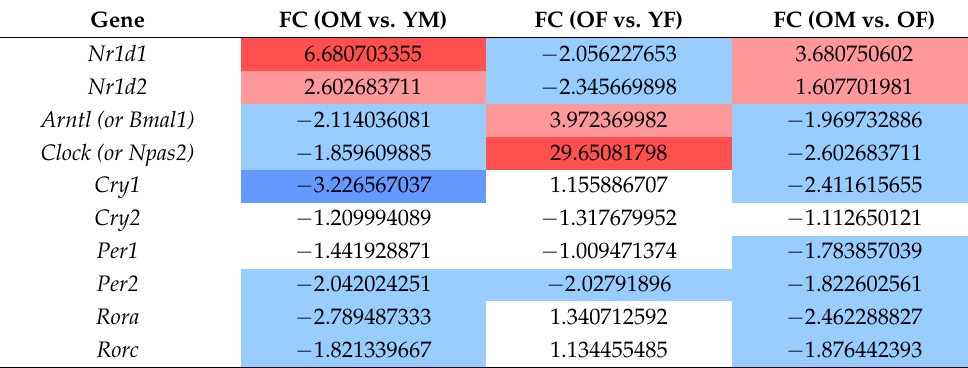
Table 2. Fold change in genes related to circadian rhythm. Gene FC (OM vs. YM) FC (OF vs. YF) FC (OM vs. OF) Nr1d1